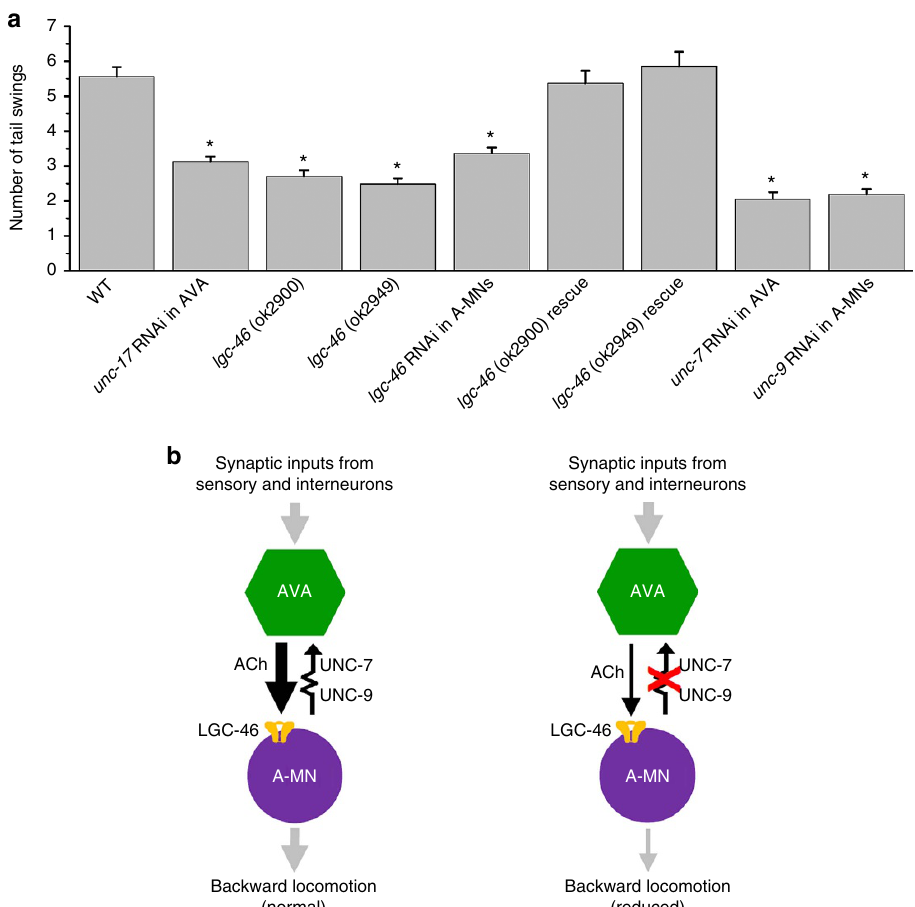
Figure 8 | Chemical and electrical synapses between AVA and A-type cholinergic motor neurons (A-MNs) interact to control backward